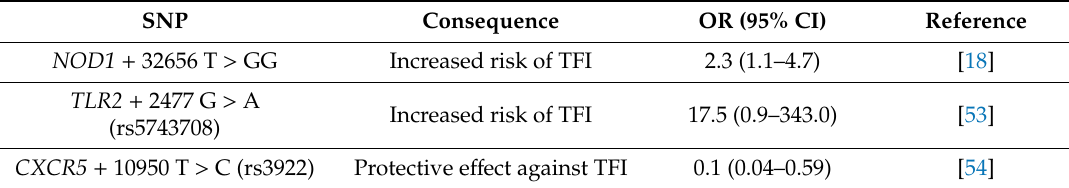
Table 1. Description and statistics for selected single nucleotide polymorphisms (SNPs) found to be associated with increased risk or protective e ff ect in Chlamydia-associated tubal factor infertility (TFI). The first two results are based on research performed on Dutch female patient cohorts, whereas the third represents a combined odds ratio (OR) and confidence intervals (CI) in joined Dutch and Finnish